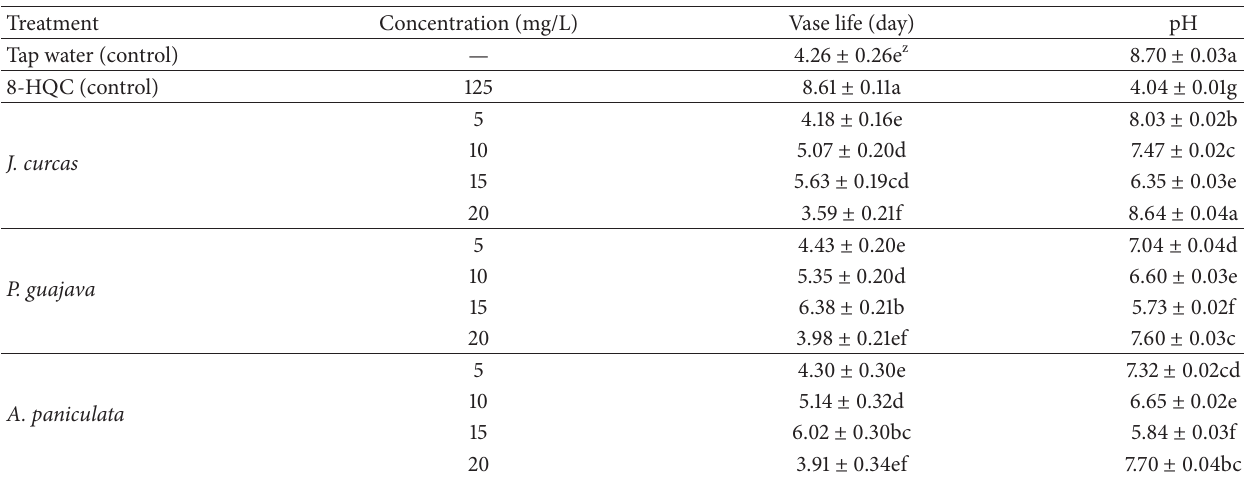
Table 4: Vase life of cut Mokara Red orchid flower and pH (final) of the flower preservative solutions as affected by Jatropha curcas , Psidium guajava, and Andrographis paniculata leaf extracts, tap water, and 8-hydroxyquinoline citrate (8-HQC). Treatment Concentration (mg/L) Vase life